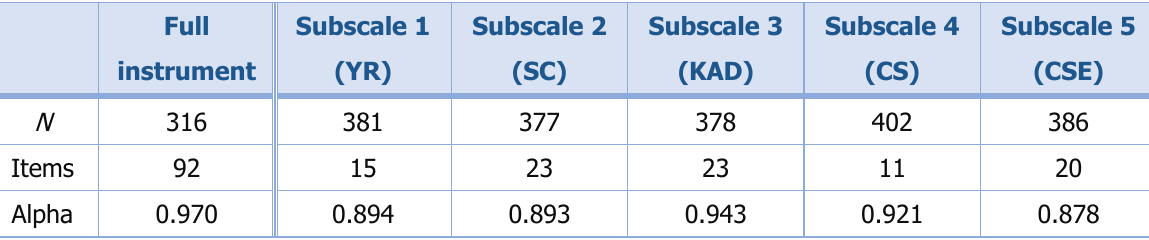
Table 2. Cronbach’s Alpha, 92 -Item Instrument